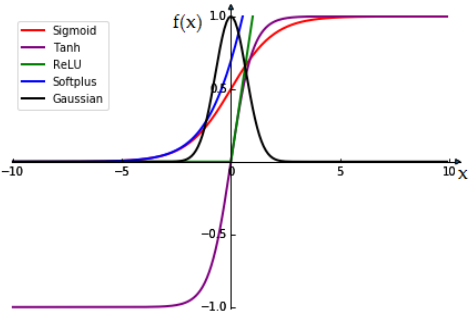
Figure 5. Activated functions.